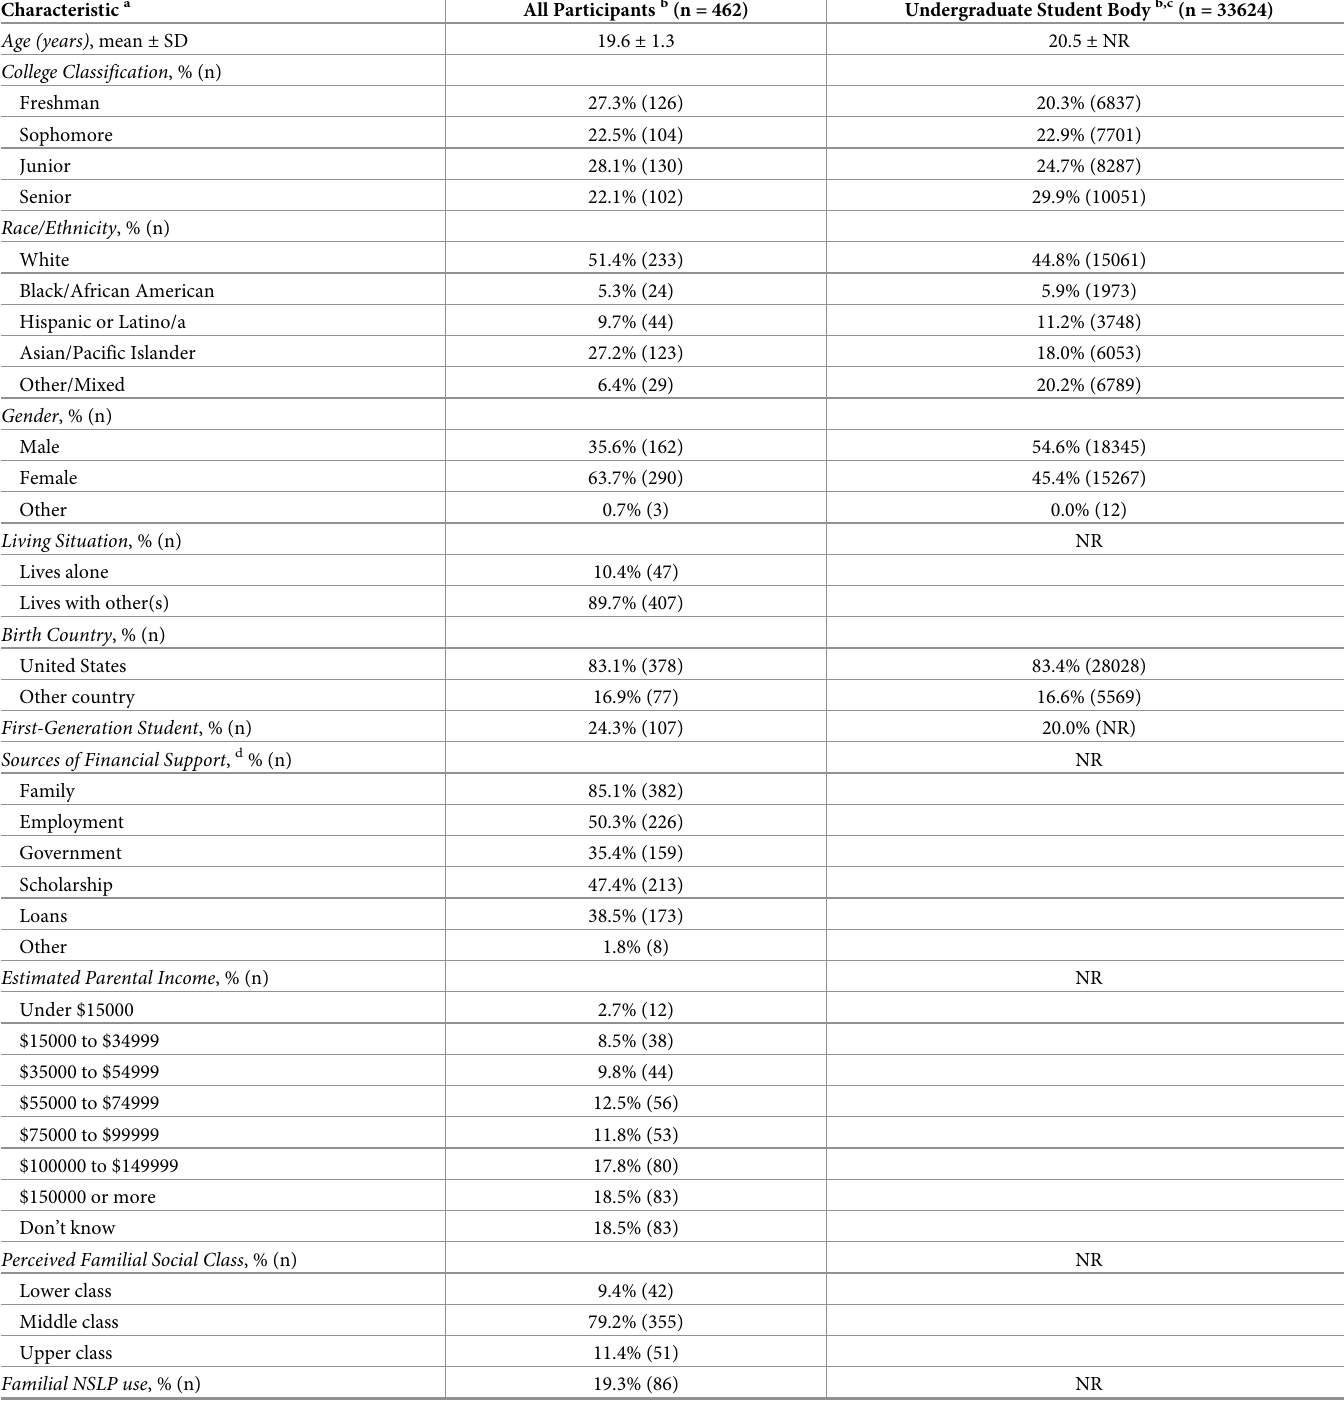
Table 2. Sociodemographic characteristics of random sample of undergraduate students who participated in an online survey and comparison with university’s undergraduate student